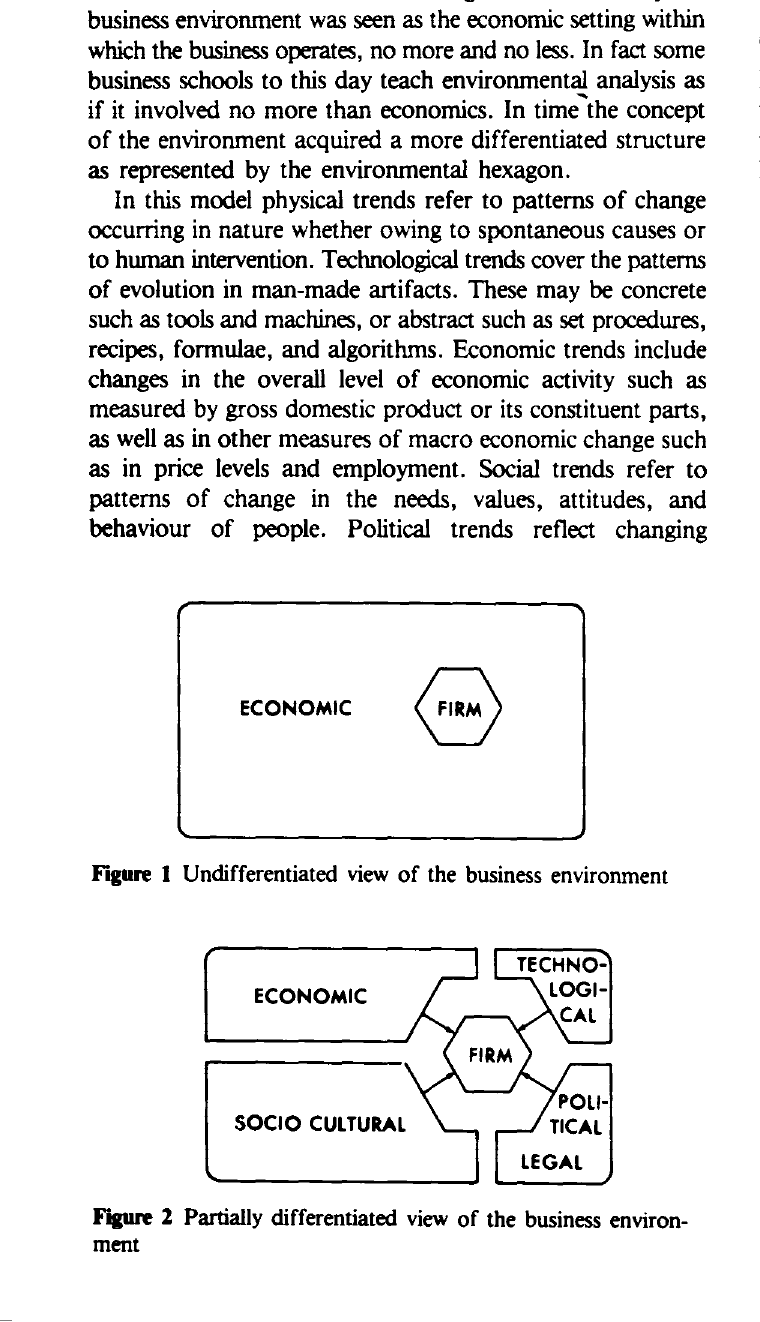
Figure 2 Partially differentiated view of the business environ ment